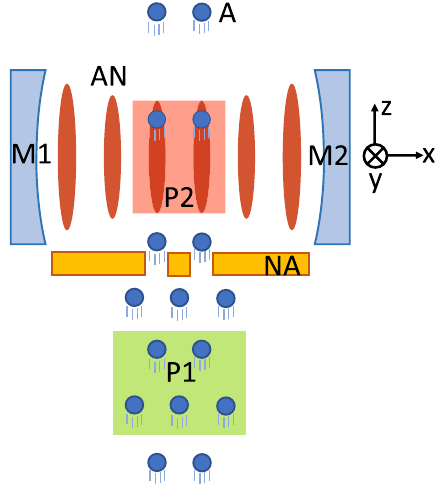
Figure 1. Our model system. M1, M2: cavity mirrors. A: a beam of atom pairs propagating in z direction. P1: the first pump laser (propagating in y direction) to prepare atoms in the superposition state. P2: the second pump beam (propagating in y direction) intersecting the cavity mode perpendicularly. AN: the anti nodes (denoted by red-filled ellipses) of the cavity field. NA: a nanohole array aperture allowing the atoms to move along the anti-nodes of the cavity field. The two pump lasers are resonant with the cavity, which is detuned from the atomic transition frequency in